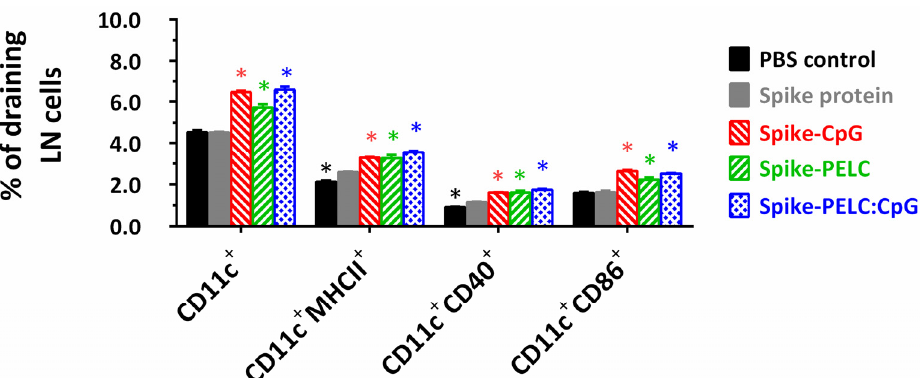
Figure 5. Cell surface expression of APCs in draining lymph nodes (LNs). The mice were given the designed formulations once every two weeks a total of three times. Two weeks after the final administration, the mice were sacrificed, and the cells from superficial cervical draining LNs were harvested and stained with fluorescence-labeled anti-CD40, anti-CD86, anti-MHC II, and anti-CD11c antibodies. The levels of CD40, CD86, and MHC II expression on live CD11c + cells were determined by flow cytometry. The positive population percentage data are represented as the mean ± standard deviation from triplicate samples of pooled LN cells. * p < 0.05 in comparison with non-adjuvanted S protein group.